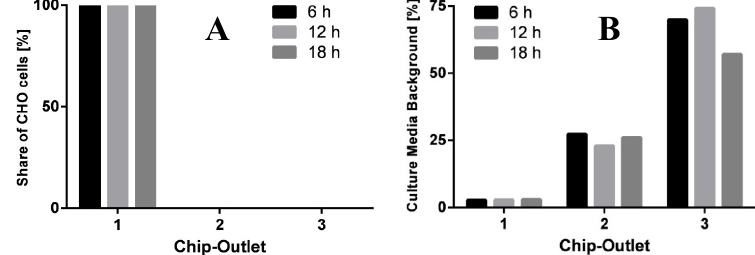
Figure 6. Distribution of CHO-K1 cells ( A ) and extracellular medium (as measure of glucose concentration) ( B ) at chip outlets 1, 2 and 3 after a total operation time of 6 h, 12 h, and 18 h at a pressure of 2